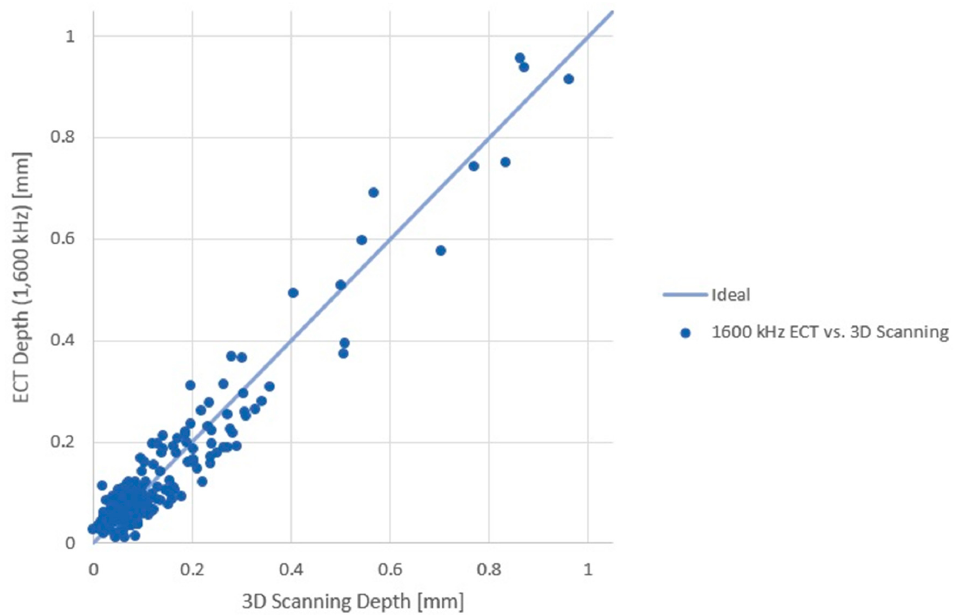
Figure 6. Dent depth (ECT) vs. dent depth (3D scanning method).